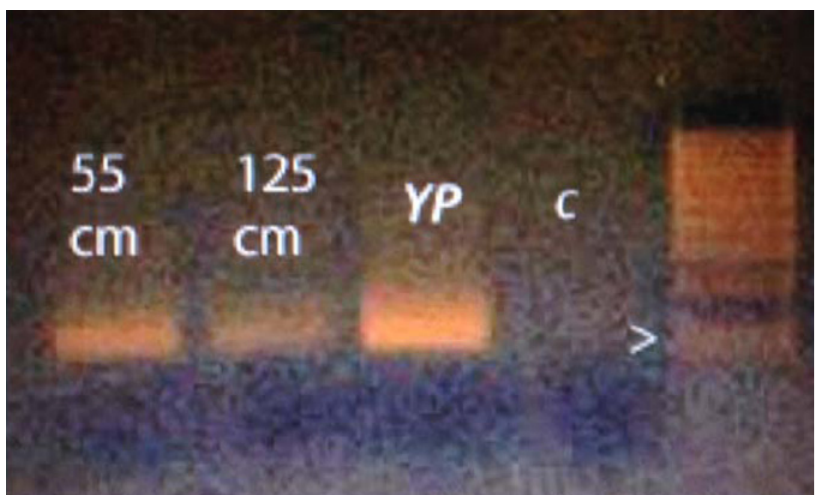
Fig 3. Representative results of gel electrophoresis of amplified DNA. Shows the presence of the yellow perch barcode sequence (CO1) in sediment samples from 55 cm and 125 cm depths in the Lower Saint Regis core. YP = Yellow perch barcode. C = No-template control lane. Arrow indicates 100 base pair position on molecular ruler lane.